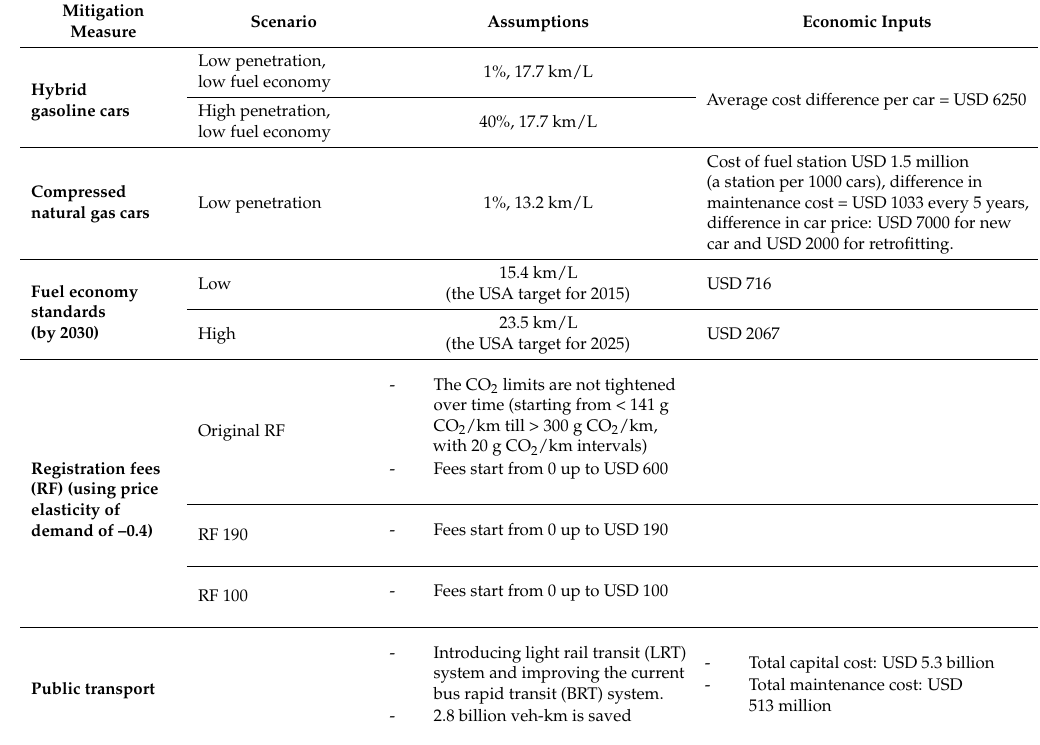
Table 2. Assumptions used to build mitigation scenarios (adapted from